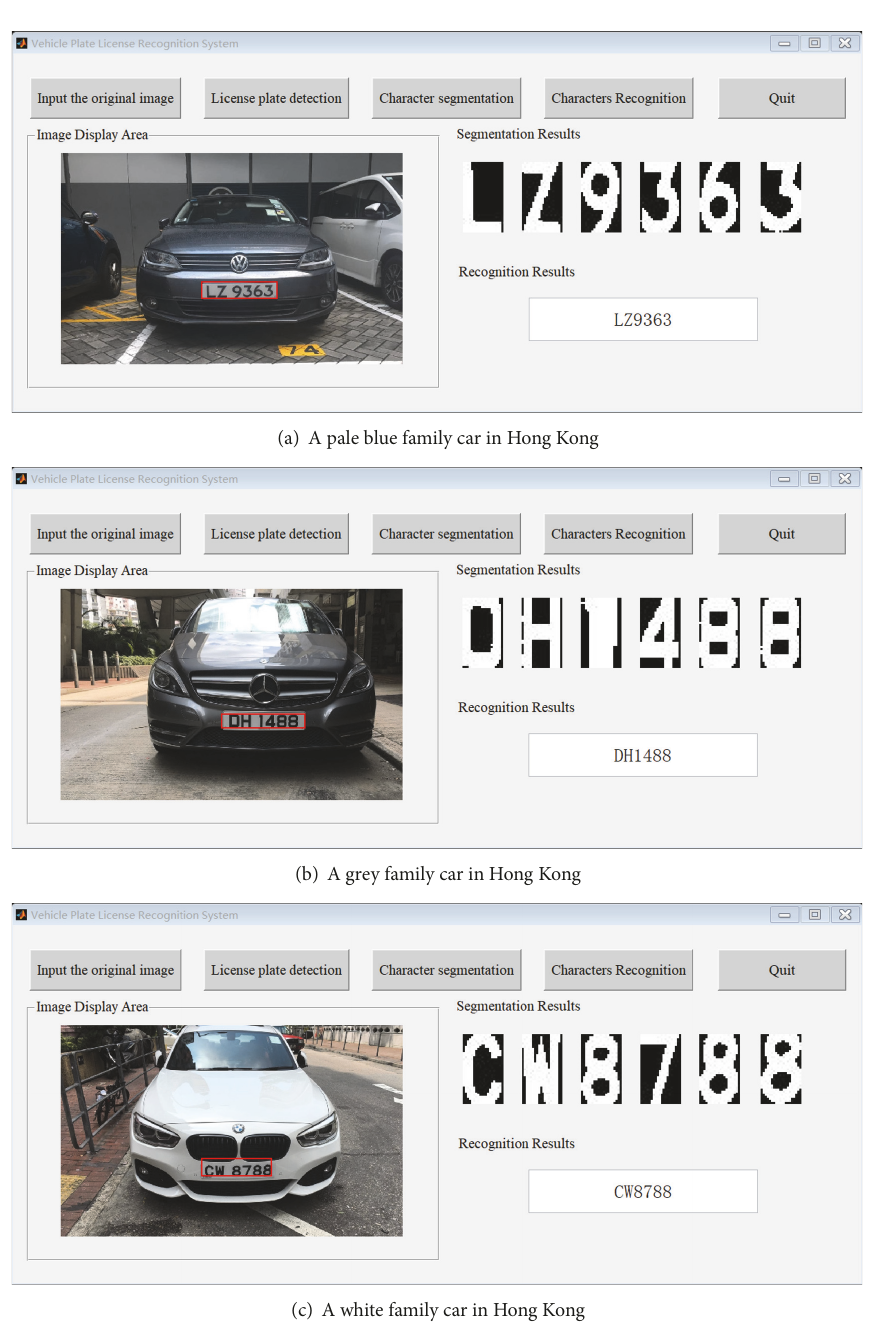
Figure 18: Recognition results of several Hong Kong vehicle license